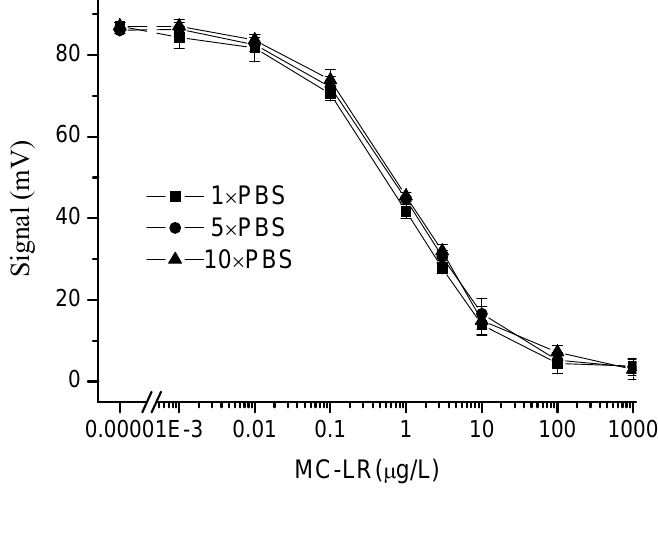
Figure 1. Effect of the ionic strength on the MC-LR immunoassay based on EWAI. Different concentrations of PBS (1×, 5×, and 10×) were used to prepare the standard solutions and antibody solutions and tested by using